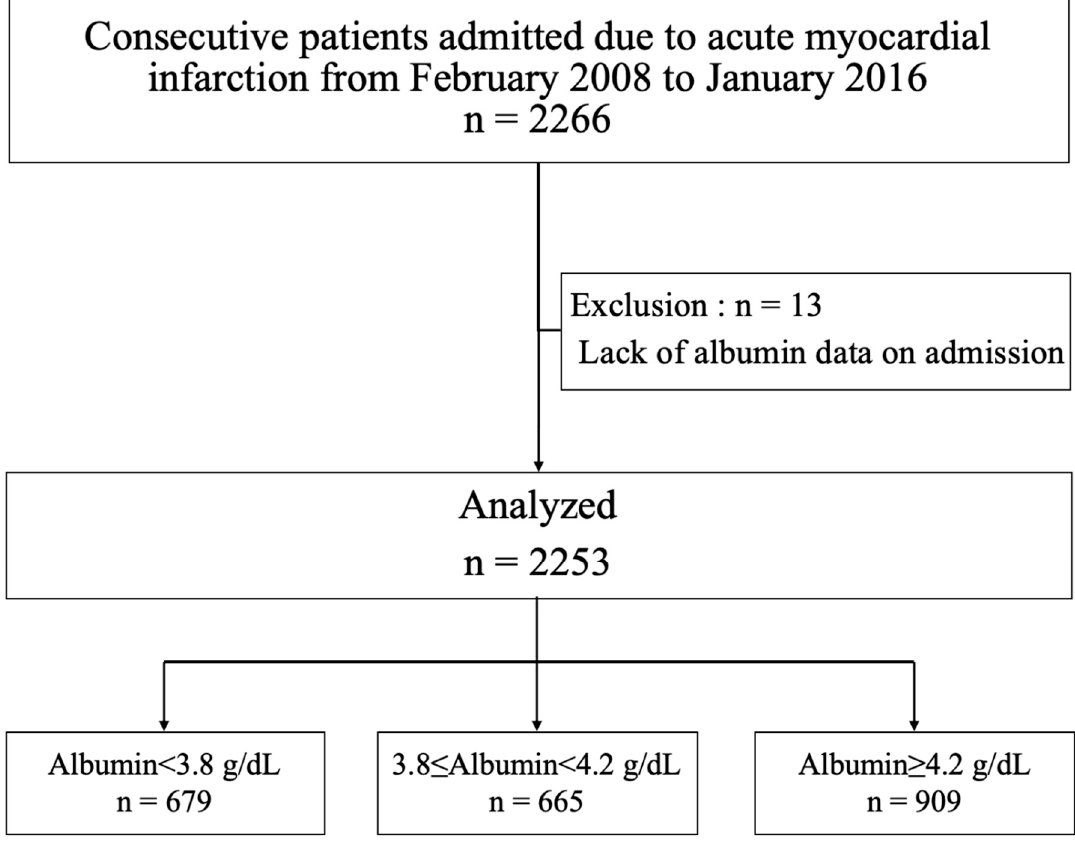
Figure 1. Flow diagram of the study cohort.